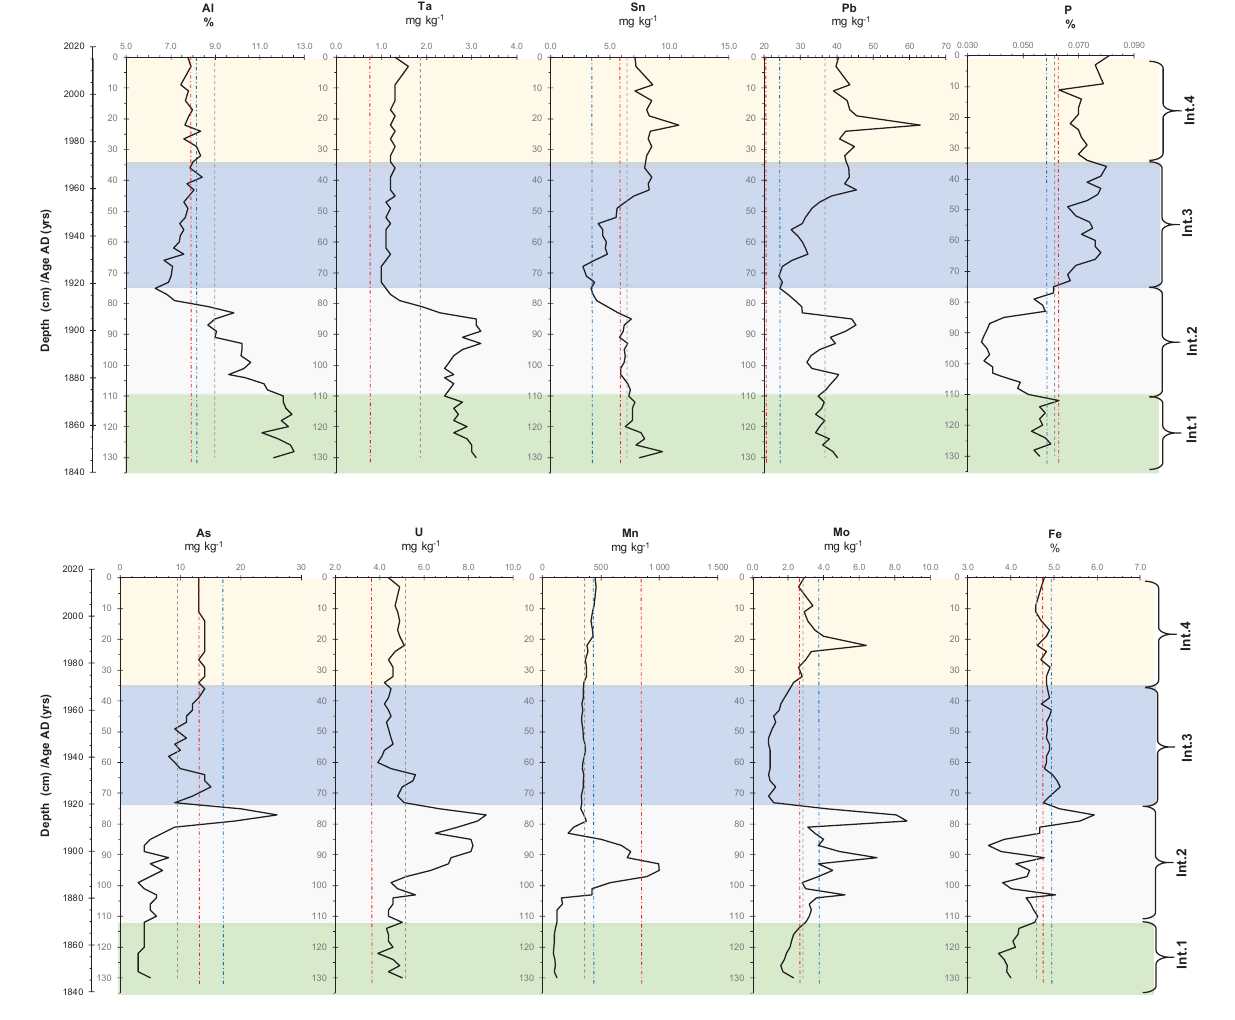
FIGURE 3 | Chemical element concentrations as a function of depth and age (Anno Domini or AD). Based on the analyzed data, four intervals (Int.) are highlighted. Red and blue dashed vertical lines correspond to global baseline values for shale (Turekian and Wedepohl, 1961) and for local fine sediments (Pinto et al., 2019), respectively. The gray dashed vertical line represents the average value for the